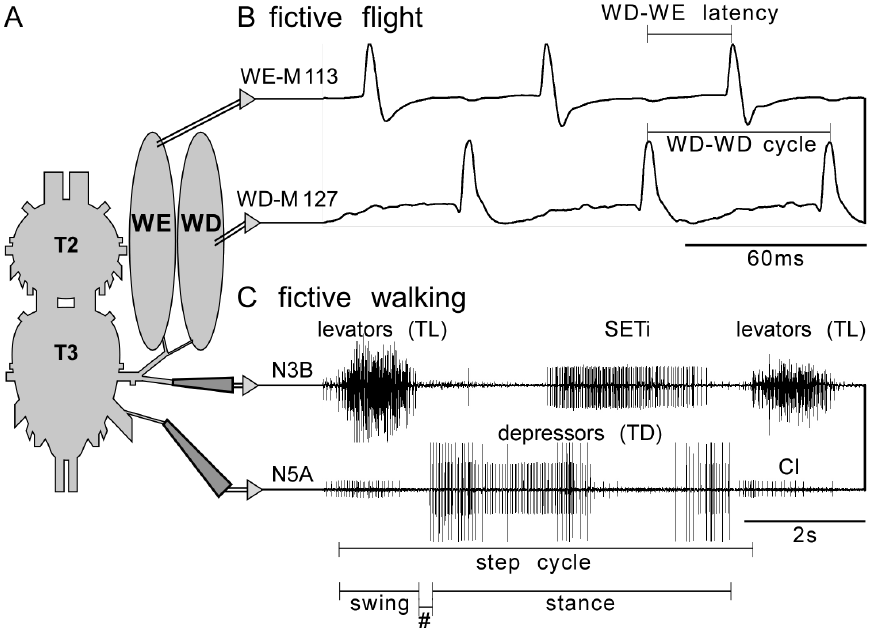
Figure 1. Schemata showing the standard preparation. A deafferented ganglia (T2 meso- T3 metathoracic) with intact nerves to a wing elevator and wing depressor muscle (WE-M113, WD-M127) and severed nerves to leg muscles: N3B, which carries seven trochanteral levator motoneurons (TL) that innervate muscle M131 and the slow extensor tibiae motoneuron (SETi) to muscle M135; N5A, through which the common inhibitor (CI) and slow and fast trochanteral depressor motoneurons project to innervate the trochanter depressor muscle (TD, M133A). B Electromyograms from WE-M113 and WD-M127 showing fictive flight induced by bath application of the muscarinic agonist pilocarpine. We evaluated the rhythm cycle length (WD-WD), the WD-WE latency and the phase of the elevator in the depressor cycle (WE/WD-WD - not indicated). C Nerve recordings from nerves N3B and N5A showing fictive walking evoked by pilocarpine. The TL units in N3B serve to monitor the swing phase and the TD units the stance phase. We measured step-cycle length (TL-TL), the length of the swing phase (TL burst length) and the TL-TD latency ( # , end of TL burst to begin of TD activity). Further details in text.